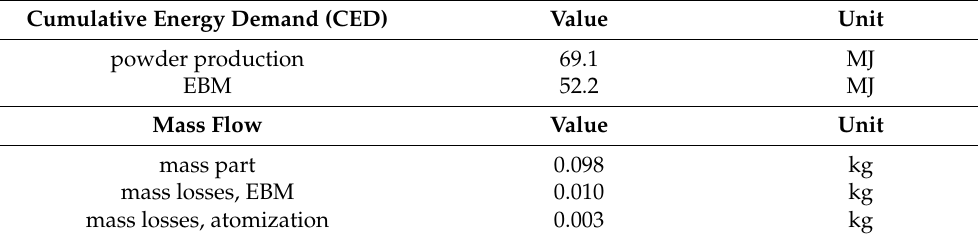
Table 2. Cumulative Energy Demand and mass flow per sample.